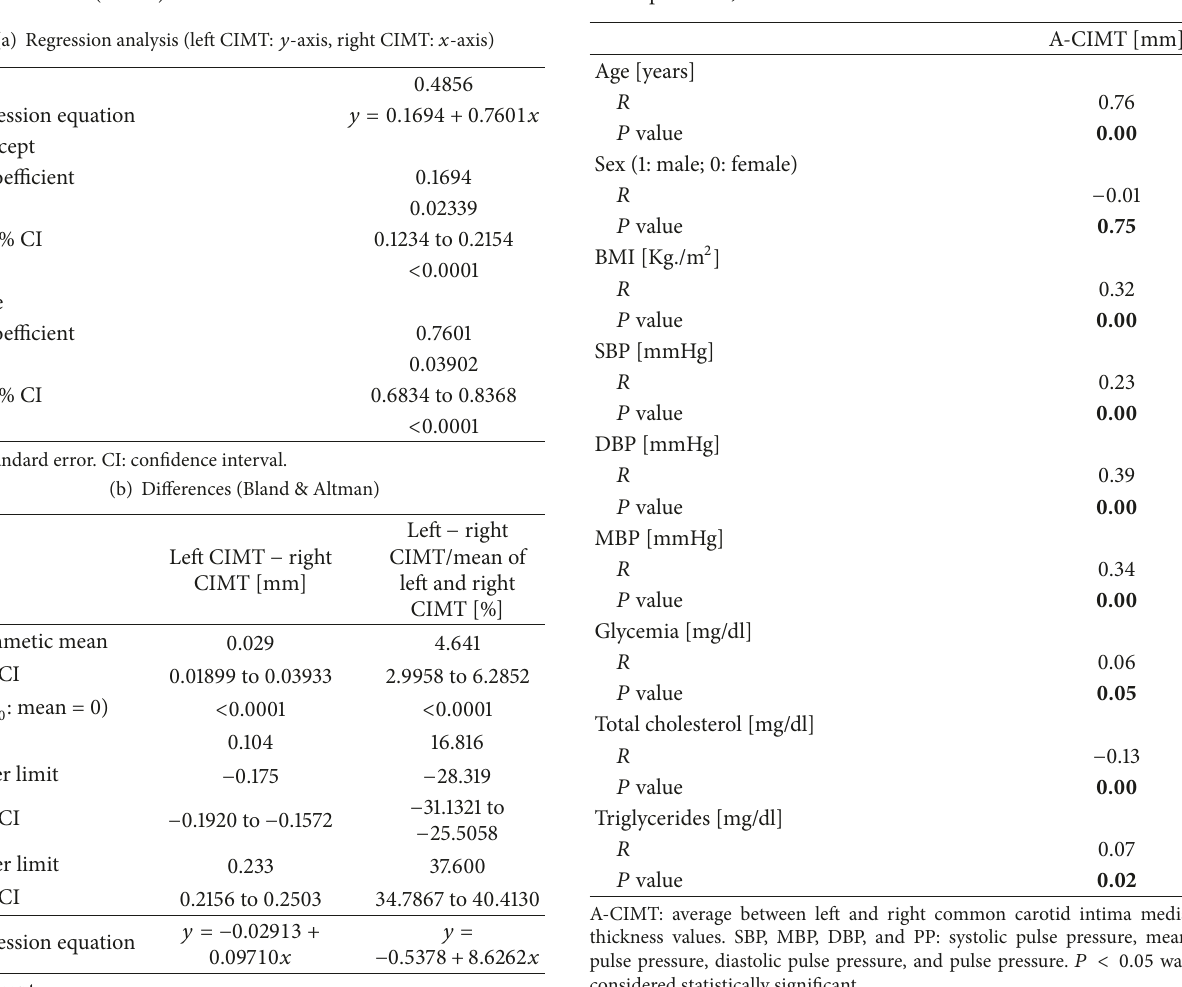
Table 3: Correlations between A-CIMT and subjects demographic, anthropometric, and blood